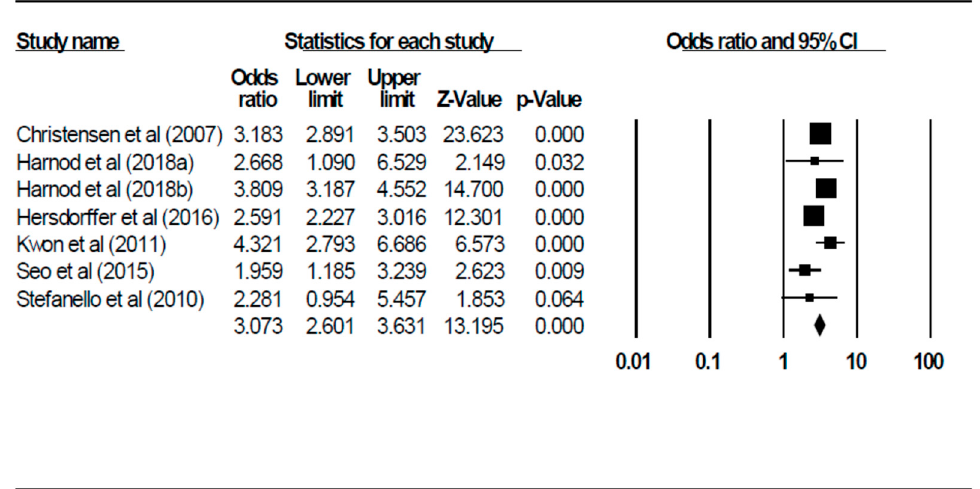
Figure 2. Forest plot of pooled odds ratio of suicide attempts among PWE and controls from case-control studies. CI, confidence interval.